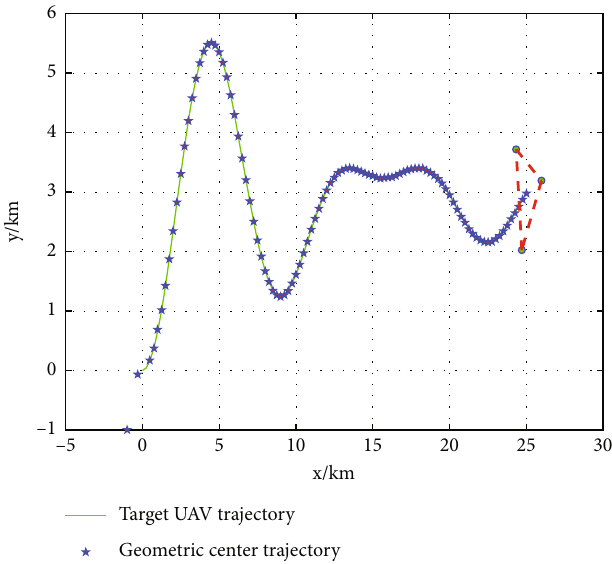
Figure 6: The geometric centre trajectory of the proposed